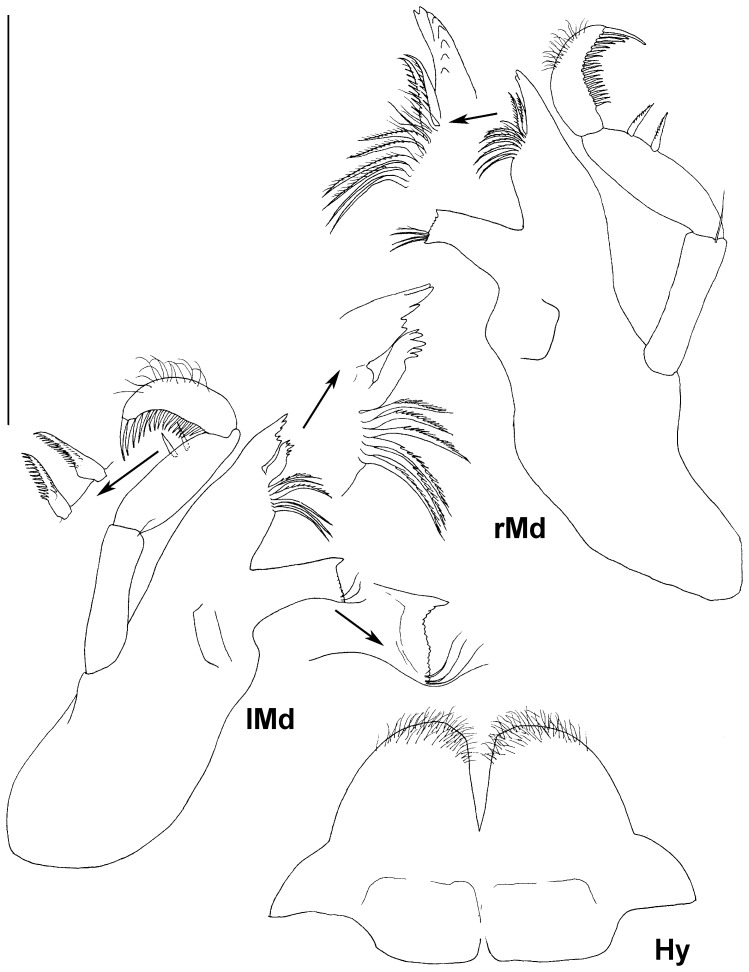
Paratype ZMH K-44089, female, mandibles, hypopharynx, scale – 0.5 mm.